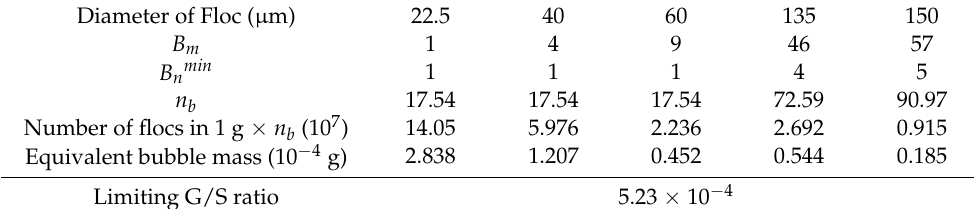
Figure 7. Effluent SS concentrations as functions of G/S ratio in continuous EF experiments, in comparison with the limiting G/S ratio from the theoretical calculation. Table 2. Calculation of limiting G/S ratio corresponding to downflow rate of 0.87